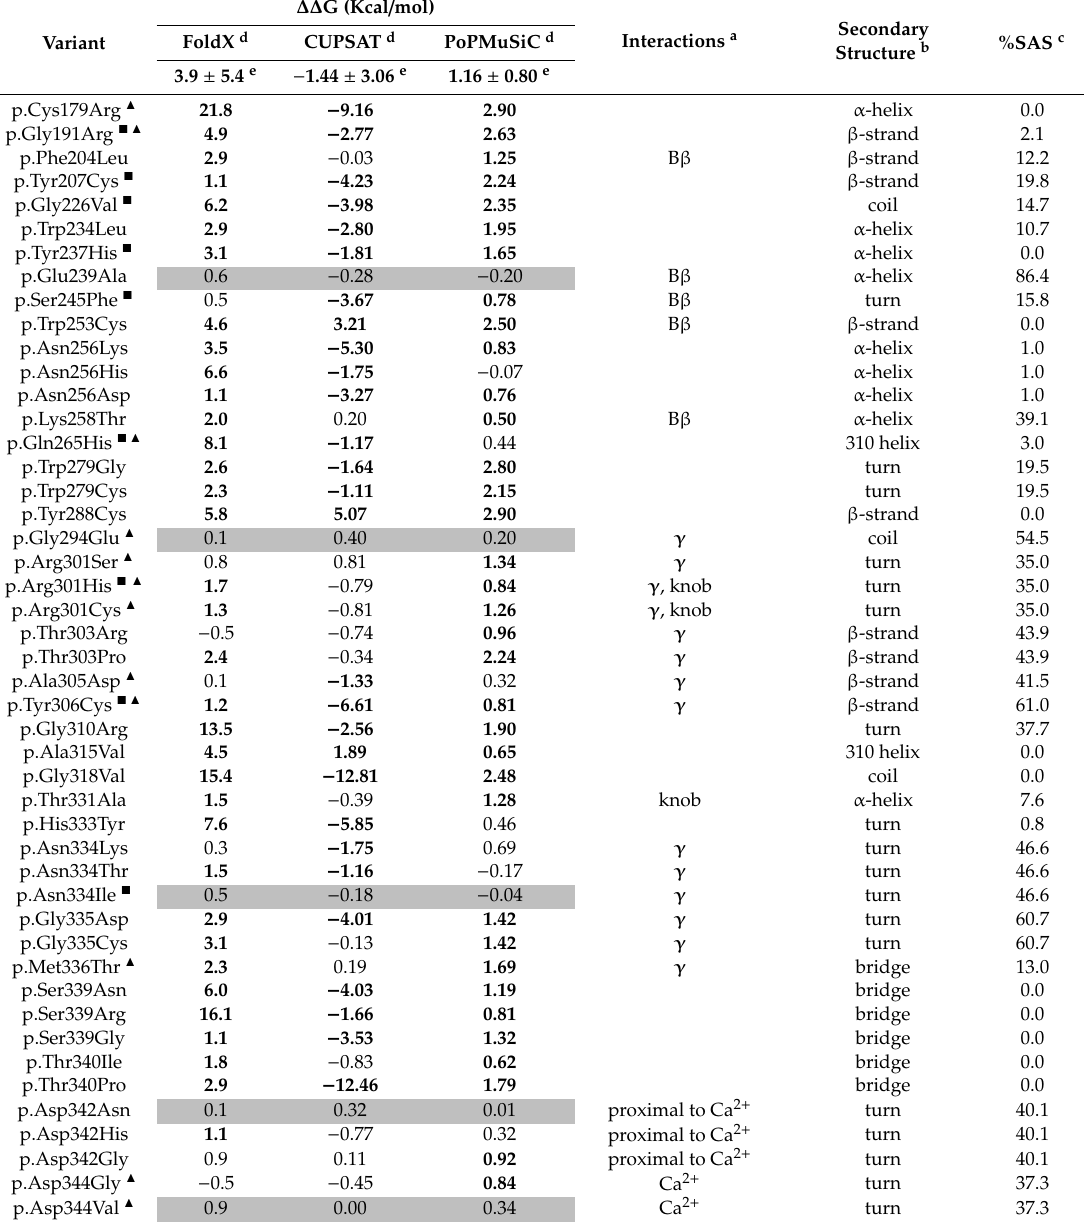
Table 1. ∆∆ G values of γ -module HGMD missense